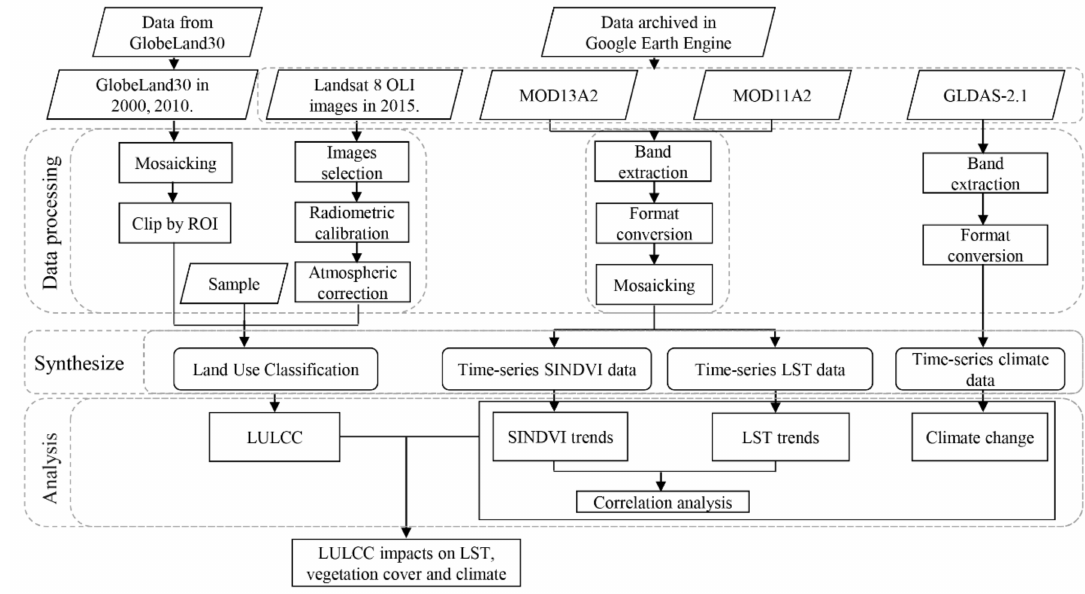
Figure 2. Workflow of the study. GLDAS: Global Land Data Assimilation System; ROI: region of interest; LULCC: land use and land cover change; SINDVI: seasonally integrated normalized di ff erence vegetation index; LST: land surface